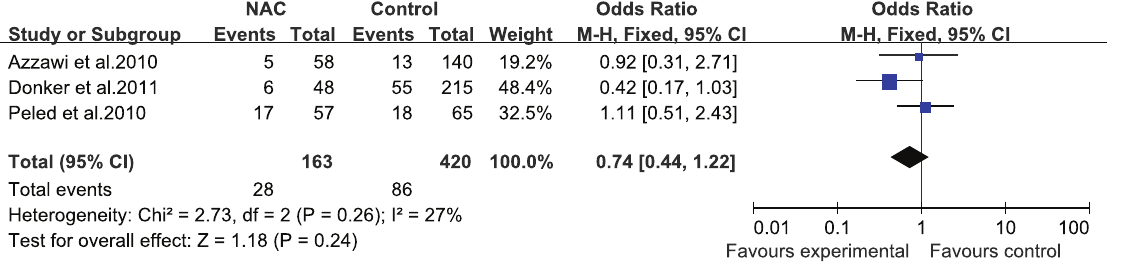
Figure 5. Pooled results of infections in patients treated with NAC. The size of the solid squares is inversely proportional to the variance of the study estimate. The diamond represents the fixed effects odds ratio and 95% confidence interval.